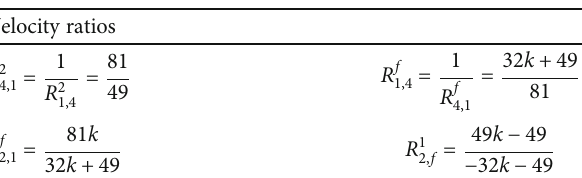
Table 2: Velocity ratios of the example